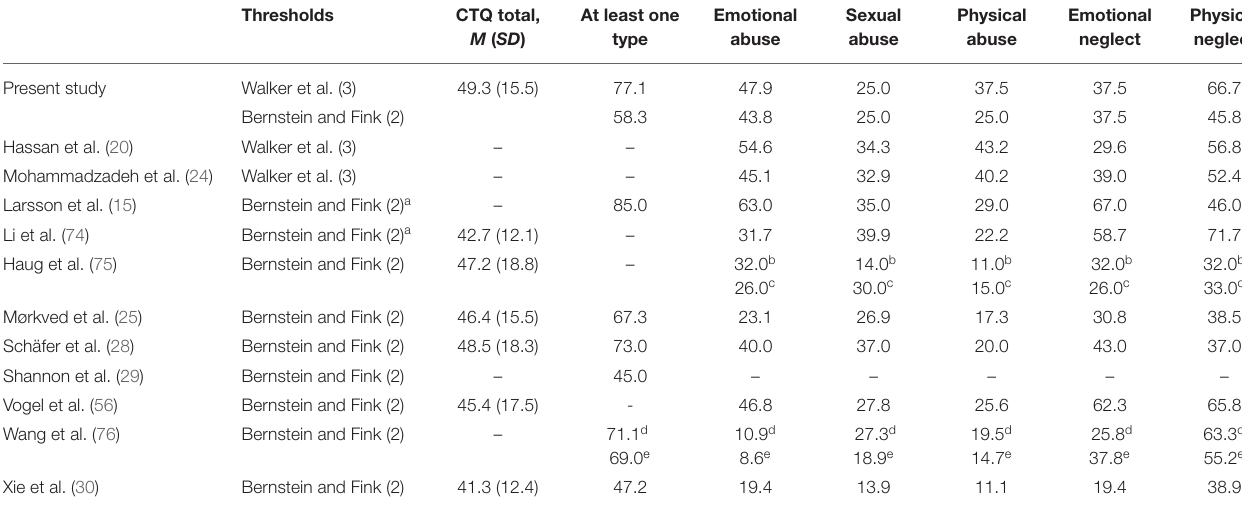
TABLE 4 | Summary of prevalence rates in SSD patients reported in previous studies (in